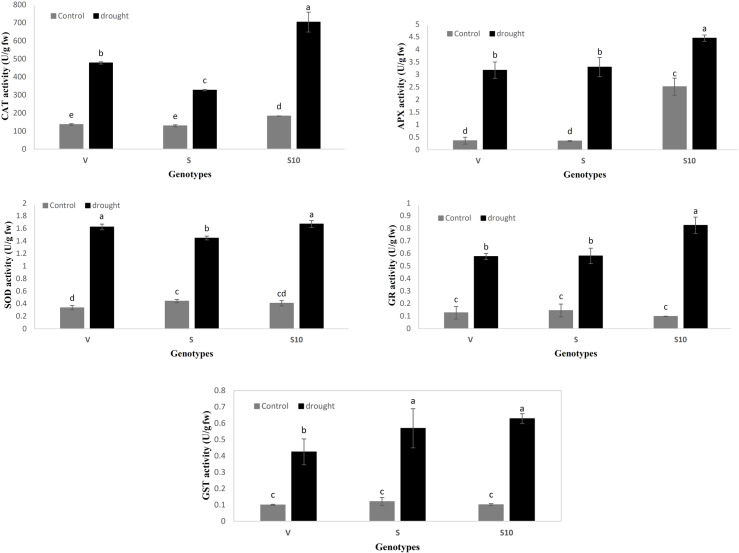
Antioxidant enzyme activities of three genotypes of Lolium perenne under drought stress.Bars represent standard error. Mean values followed by the same letter are not significantly different (p < 0.05). Different letters indicate significant differences by LSD test at P < 0.05, n = 3. V = vigor genotype, S = speedy genotype.